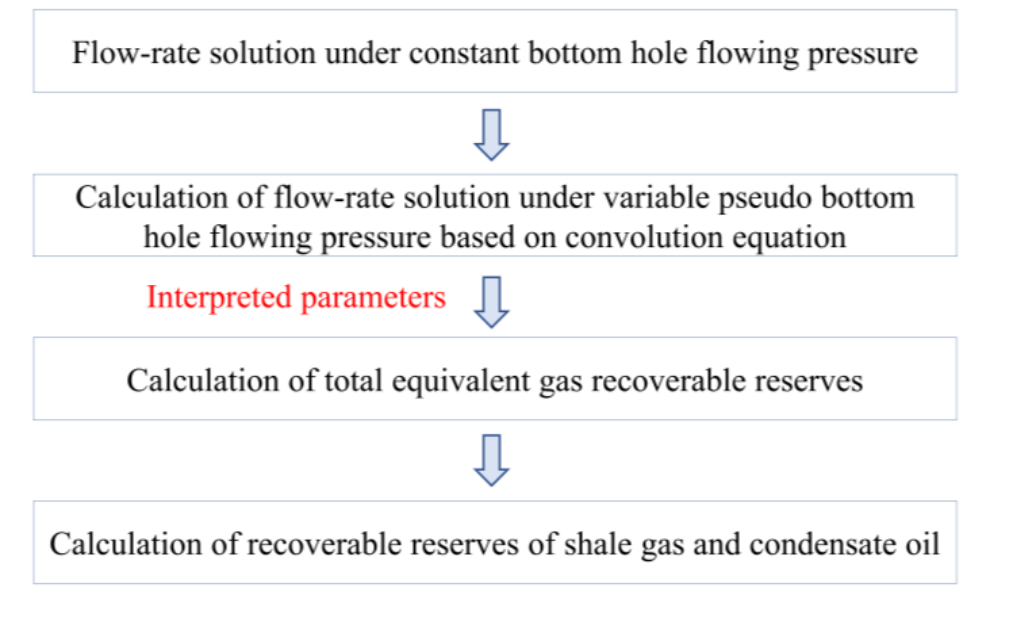
Figure 3. The flow chart of the dynamic productivity prediction method for shale condensate gas reservoirs based on the convolution equation.